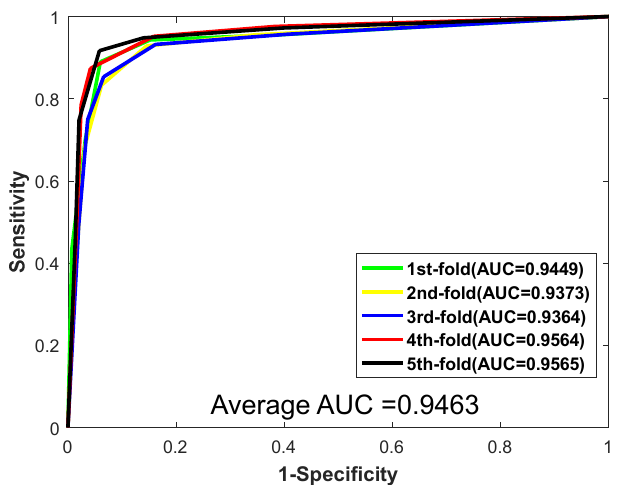
Figure 3. ROC curves yielded by RF on H. pylori .